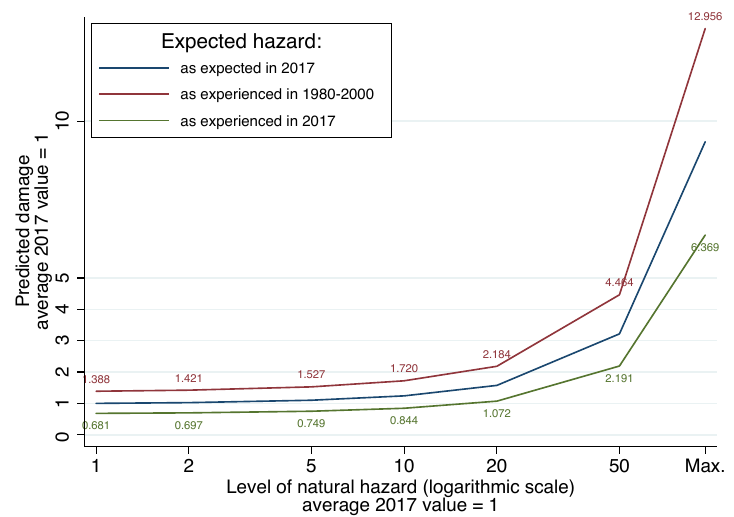
Figure 7. Adaptation model results. Predicted damage over levels of natural hazard (flooding) and scenarios of hazard expectations (average 2017 damage D and hazard H = 1) with constant exposure (exposure X = average 2017